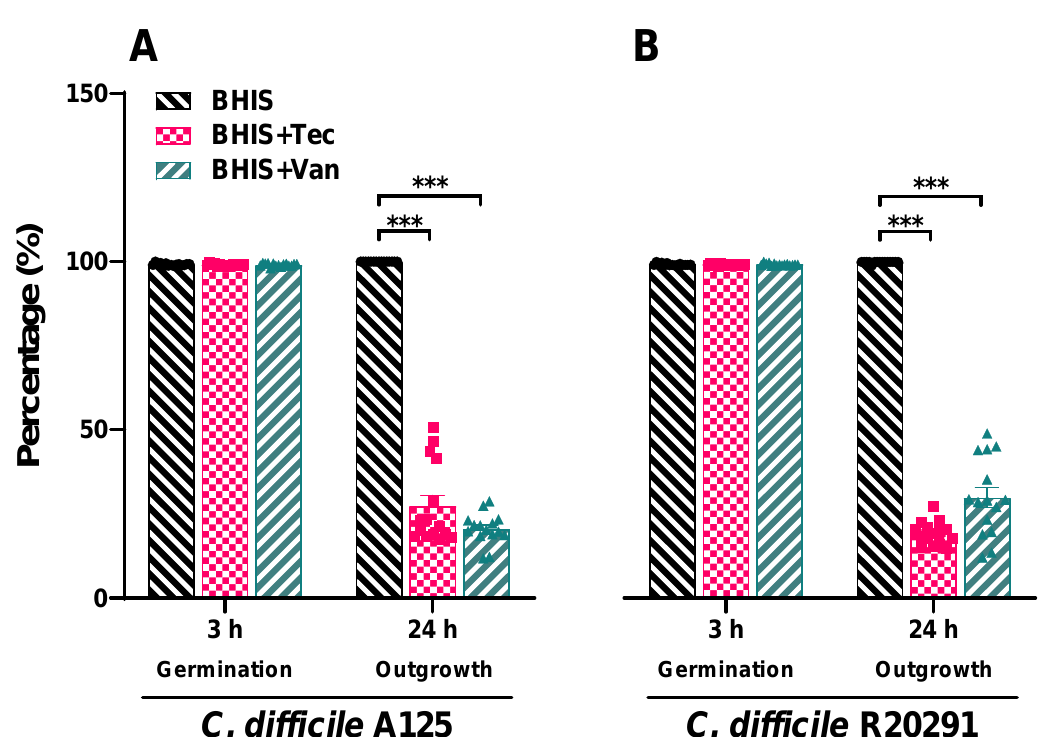
Figure 6. Teicoplanin and vancomycin significantly reduce outgrowth in C. difficile ( A ) A125 and ( B ) R20291 as determined by differential staining assay. C. difficile spores were incubated with BHIS medium alone or medium supplemented with 1 × MIC of either teicoplanin or vancomycin for 24 h, then thoroughly washed and stained with a Wirtz–Conklin stain. All the micrographs were taken at a magnification of 1000 × . Relative percentage of germinated spore and vegetative cells were calculated based on the count of five different fields by CellSens Dimension software. Bar graphs represent geometric means of three independent experiments and error bars represent the standard errors. Abbreviations: Tec = teicoplanin, Van = vancomycin and *** denotes p -value < 0.0001.